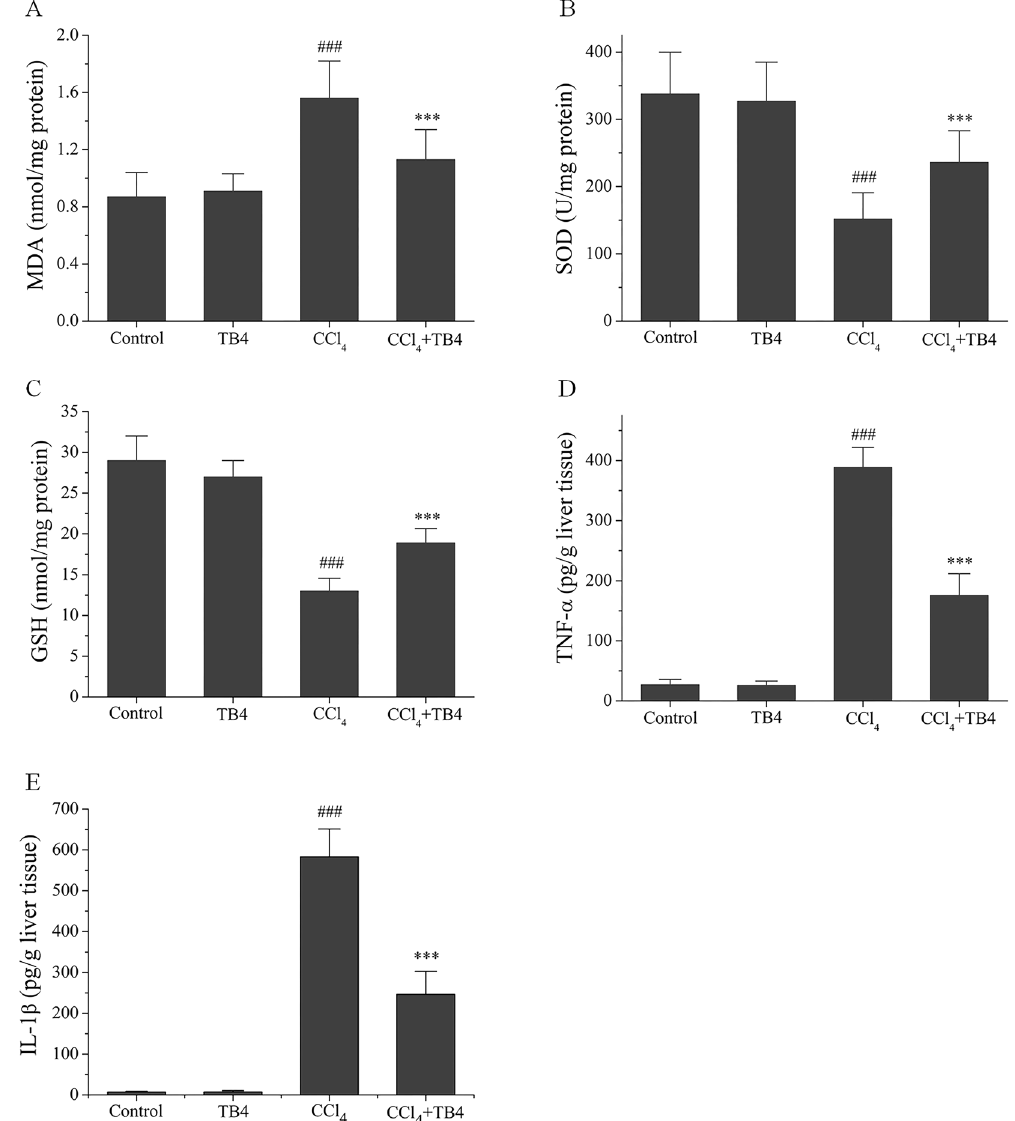
Figure 3. Effect of exogenous thymosin β 4 (TB4) on oxidative stress parameters ( A – C ) and inflammatory cytokine TNF- α ( D ) and IL-1 β ( E ) in the livers of CCl 4 -treated mice. ### P < 0.01 vs. both control group and TB4 group; *** P < 0.05 vs. CCl 4 group. (n = 10 for each